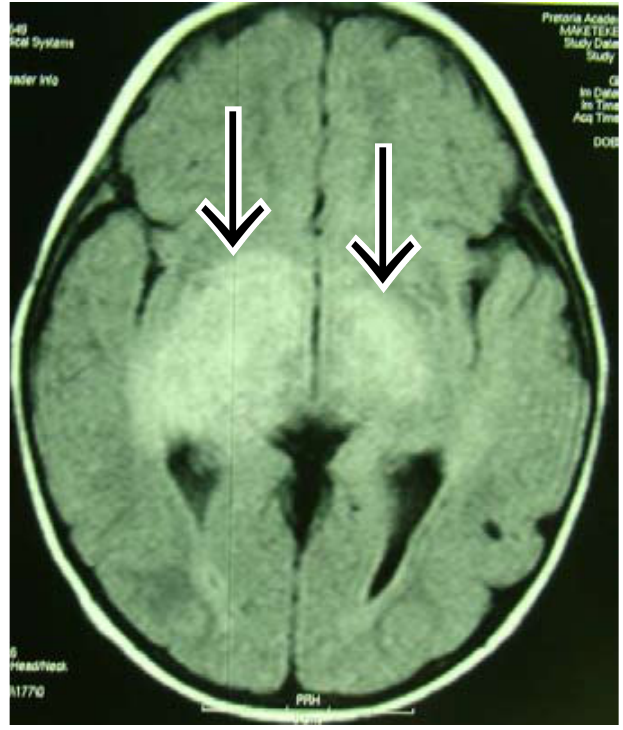
Fig. 6b. Axial FLAIR sequence of the same patient as above shows bilateral hamartomatous high signal changes in the basal ganglia (FASI) with no appre- ciable mass effect.